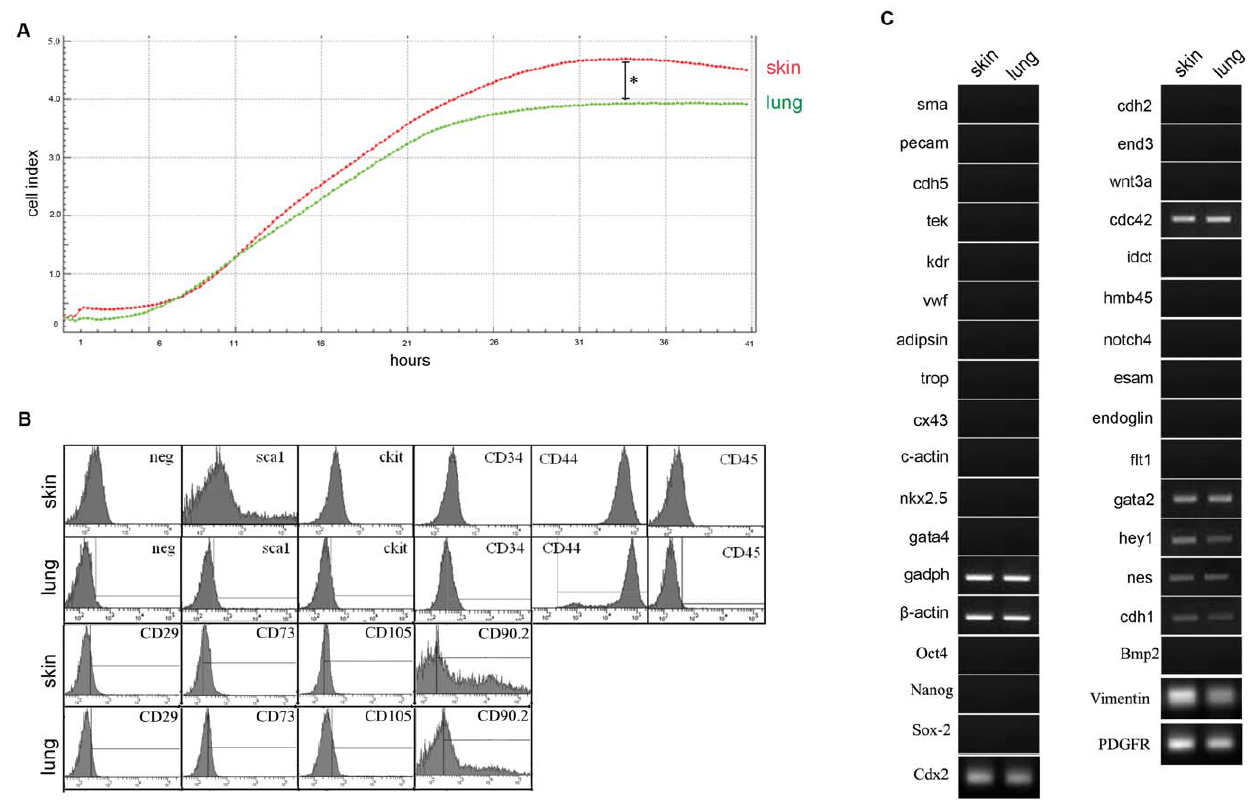
Figure 2. Characterization of skin and lung MPCs. A. Representative growth curves for skin (red) and lung (green) MPCs in complete medium. One out of nine wells of representative cultures in a Real Time Cell Analyzer is shown. Cell Index represents the relative number of proliferative cells. Differences between skin and lung were statistically significant by ANOVA (*p , 0.03). B. Flow cytometry analysis of surface molecule expression on skin and lung mesenchymal precursors. One group of representative histograms out of nine independent experiments is shown. Table 1 shows the media of the mean intensity fluorescence and the variance for all nine experiments. C. RT-PCR analysis of gene expression profile in skin and lung MPCs. The panel shows one representative agarose gel analysis of amplified products out of three independent experiments for each explant. Primer sequences are shown in Table 2 and summary of the results is shown in Table 3.